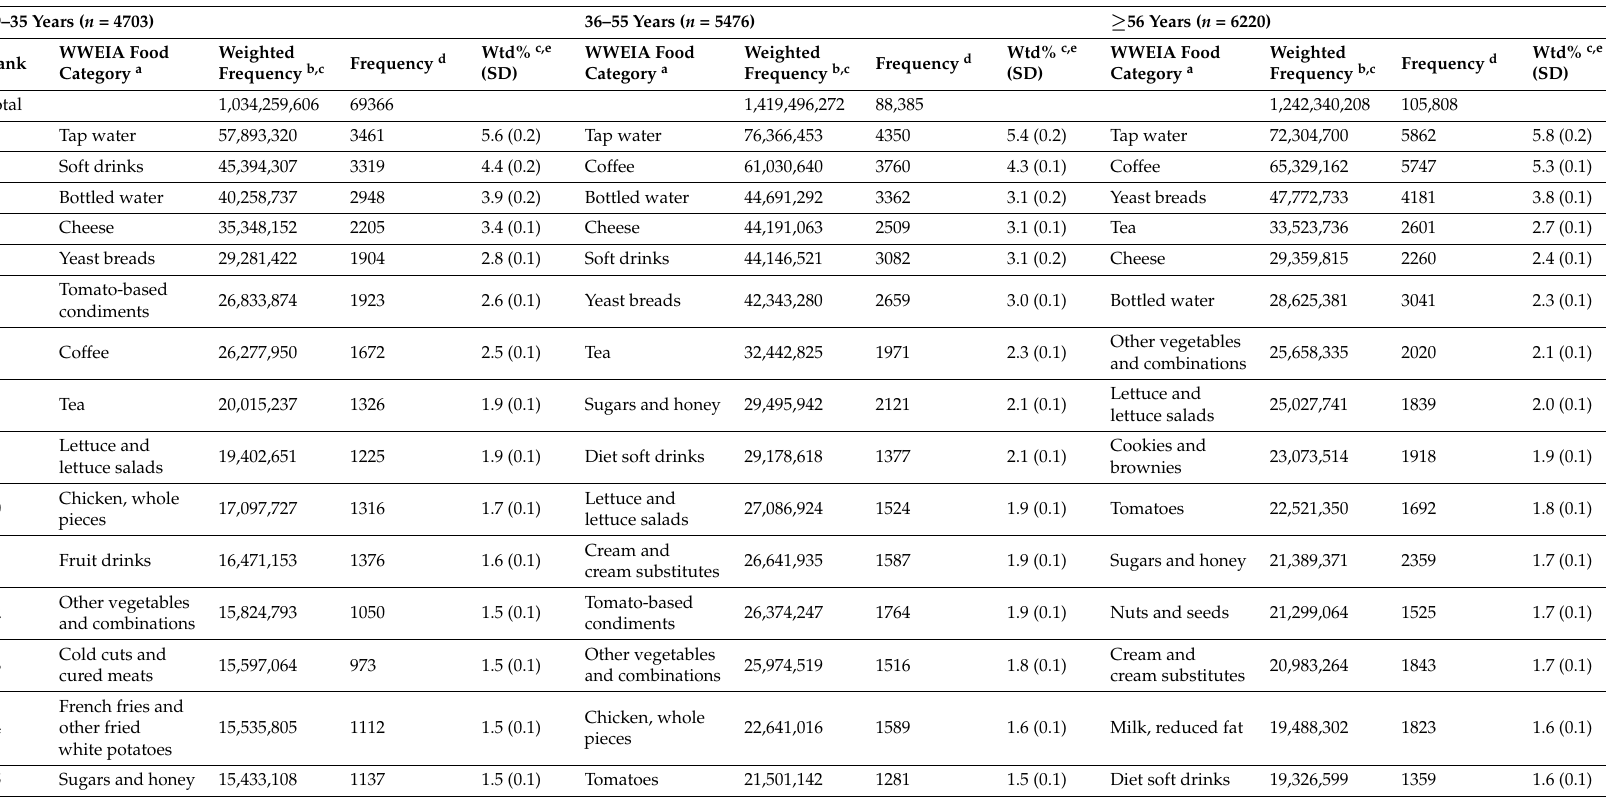
Table 4. Top 25 most frequently consumed specific WWEIA food or beverage categories a , unweighted and weighted frequency of reported intake from WWEIA food or beverage categories, percent and standard error of percent of reported WWEIA food or beverage categories among all reported WWEIA categories in U.S. adults aged ≥ 19 years from 2007–2012 NHANES